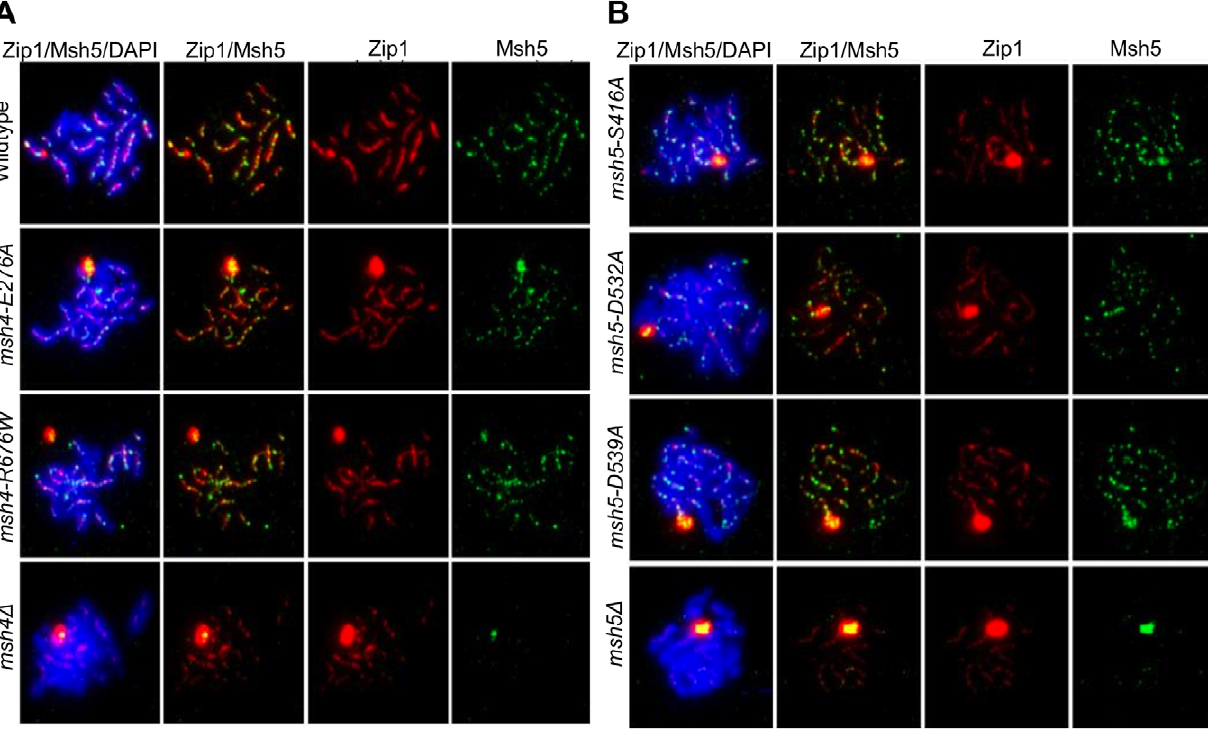
Figure 7. msh4/5 hypomorphs are defective in Zip1 polymerization. Meiotic chromosome spreads isolated from cells at 4 hr after induction into meiosis were incubated with antibodies to Zip1 and Msh5 and counterstained with DAPI. (A) Localization of Zip1 and Msh5 in wild-type, msh4- E276A , msh4-R676W and msh4 D mutants. (B) Zip1, Msh5 localization in msh5-S416A , msh5-D532A , msh5-D539A and msh5 D mutants.